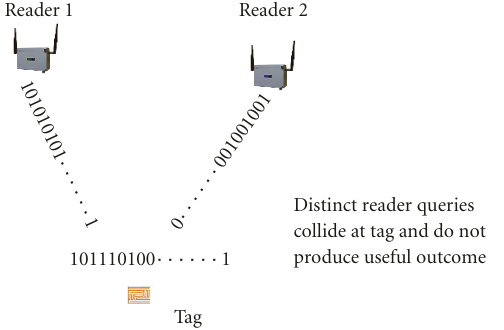
Figure 3: Figure showing that distinct reader query bits at an overlapped tag result in a corrupted query reception.